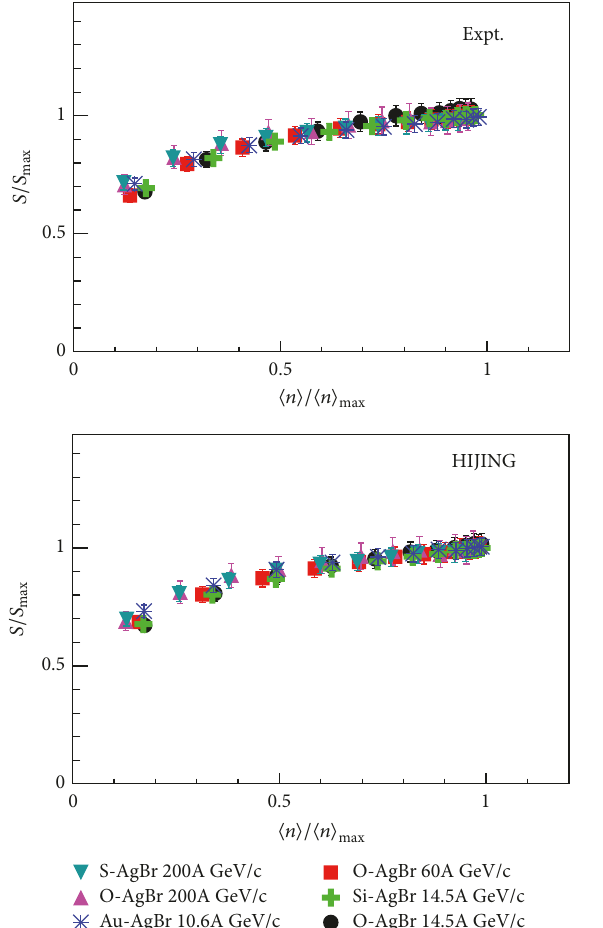
Figure 4: Dependence of 𝐷 𝑞 on 𝑞 for experimental and HIJING events. The values of 𝐷 1 (encircled) are obtained from 𝑓(𝛼(𝑞))